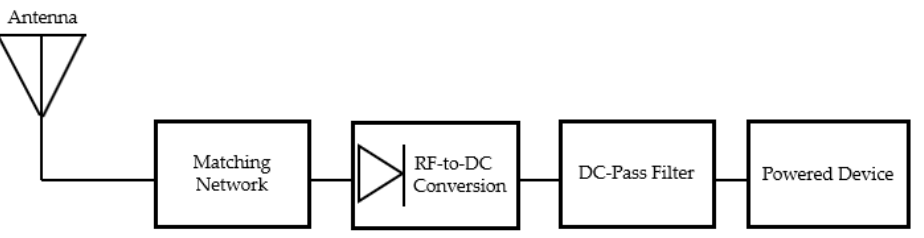
Figure 1. Typical block diagram of a RF energy harvesting system.